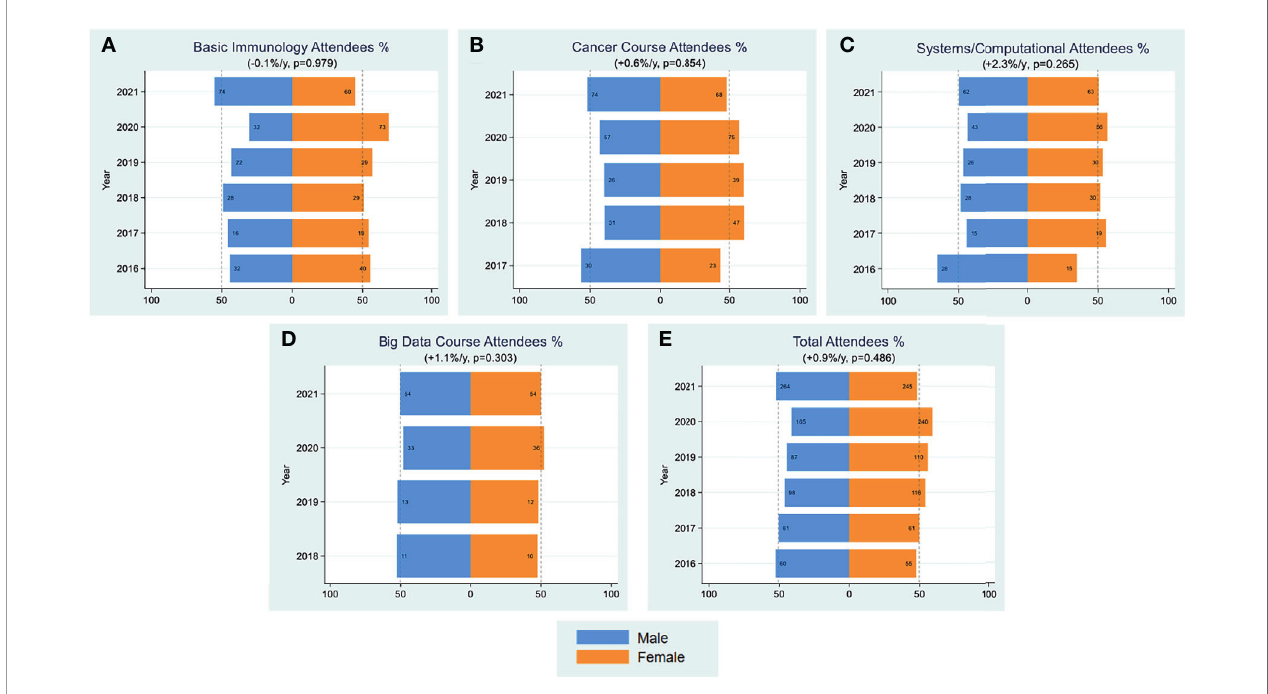
FIGURE 3 | Attendees Workshop. Yearly female percentages of attendees in workshop on subject of basic immunology (A) , cancer (B) , systems/computational (C) , big data (D) and all categories combined (E) are shown over the period 2016-2021. Percentages were based on actual numbers subjects stating their gender. Average changes per year and p-values (shown in parentheses) were estimated by the slope coef fi cient from a simple linear regression model. The cancer and big data courses were initiated in 2017 and 2018, respectively. The dotted line represents 50% as a point of reference for